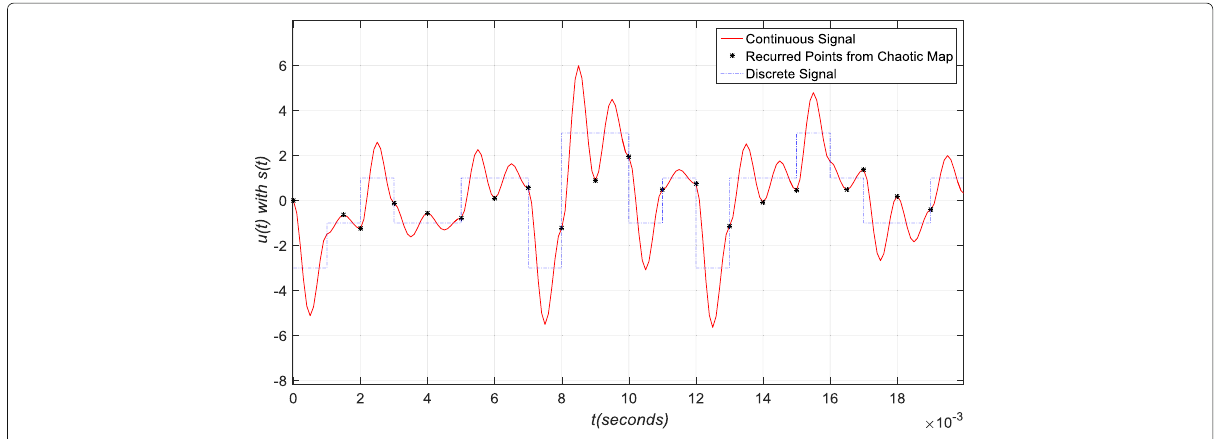
Fig. 8 Numerical simulation of proposed hybrid chaotic signal with β = 10 3 ln ( 2